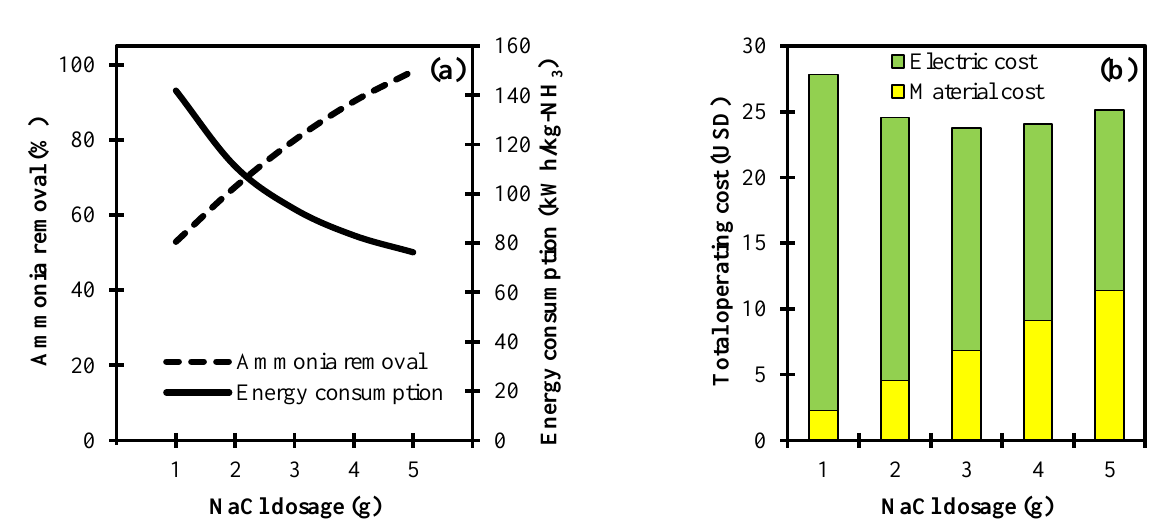
Figure 3. Process variable analyses of NaCl dosage towards: ( a ) Ammonia removal, energy consumption, and ( b ) total operating cost in an electrochemical system.